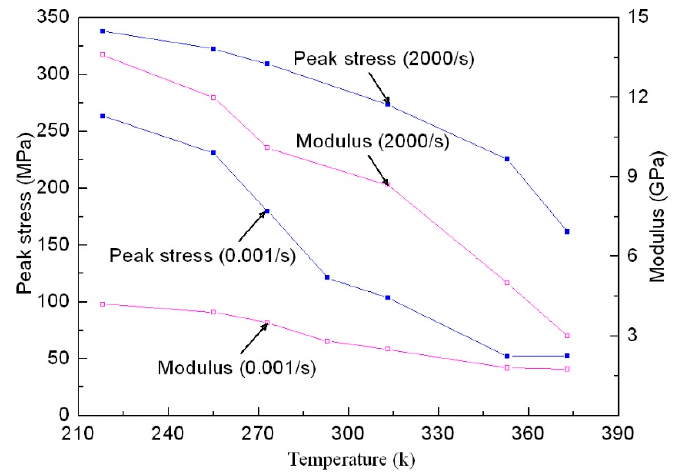
Figure 13. Relation of the peak stress and modulus of directional polymethylmethacrylate with temperature under quasi-static and dynamic